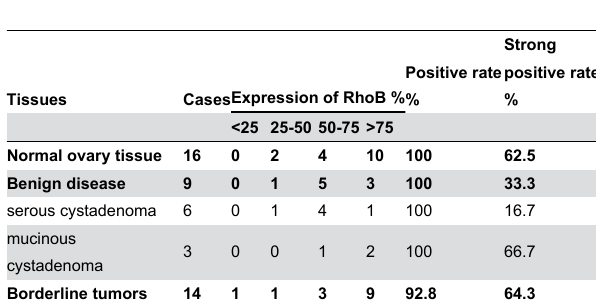
Table 1. RhoB protein levels in normal ovaries and tumor